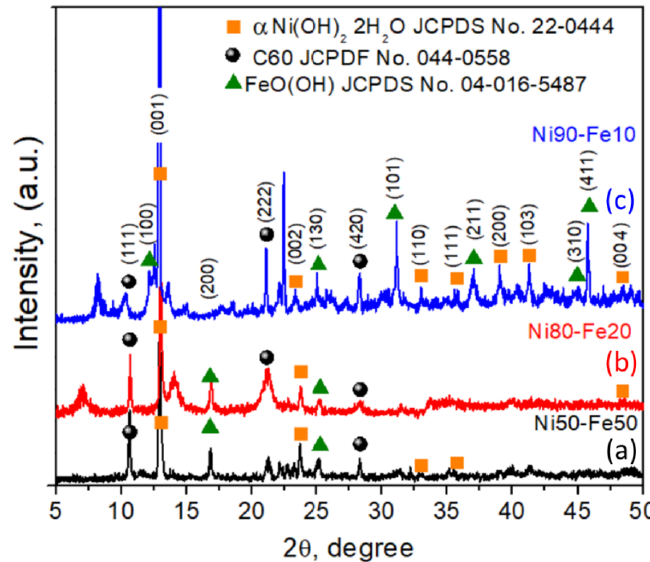
Figure 1. XRD patterns of as-prepared Ni50-Fe50 wt%, Ni80-Fe20 wt%, and Ni90-Fe10 wt% samples ( a ) Ni50-Fe50; ( b ) Ni80-Fe20; ( c ) Ni90-Fe10.